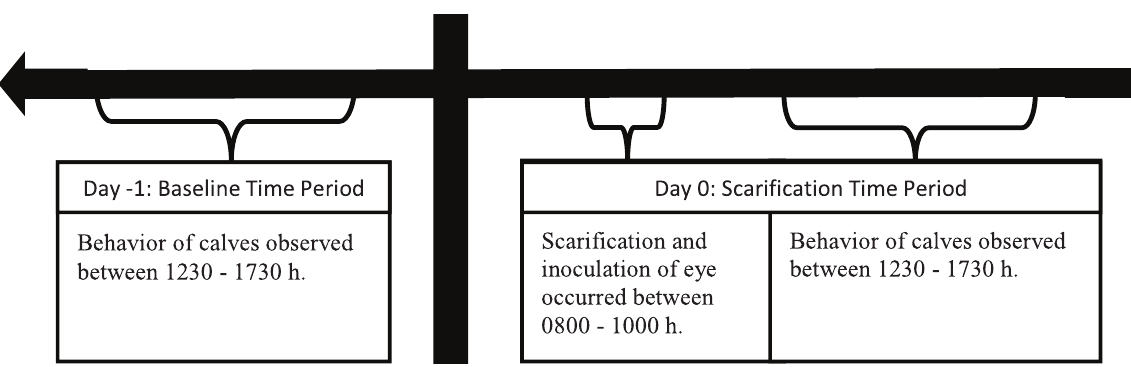
Figure 1. Timeline of